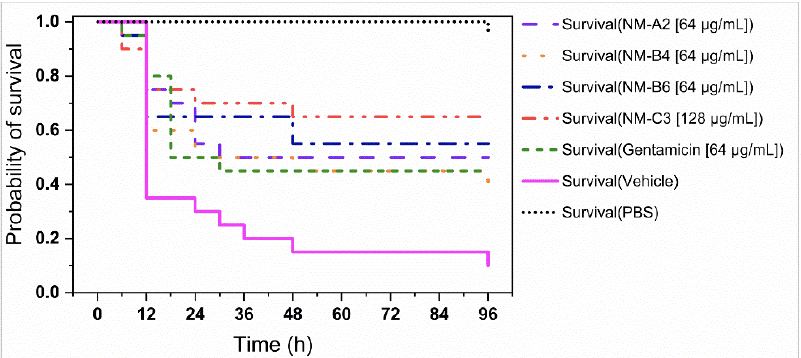
Figure 4. Kaplan–Meier survival plot showing the probability of survival of G. mellonella larvae infected with K. pneumoniae (ATCC 10031) and treated with the isolated compounds, as well as positive and negative controls.